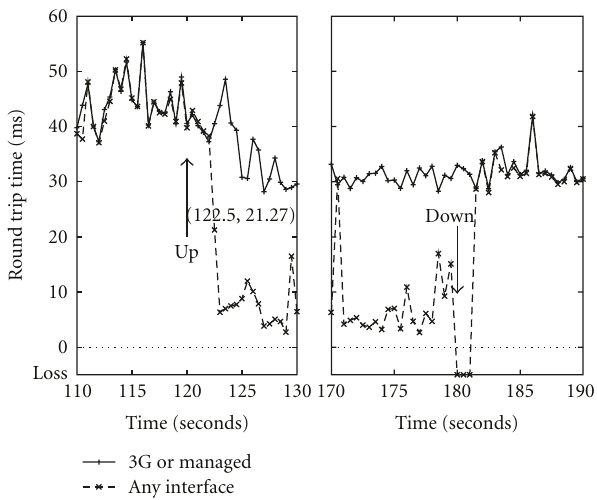
Figure 14: Closer look at the RTT values collected when the adhoc interface is turned on and o ff .